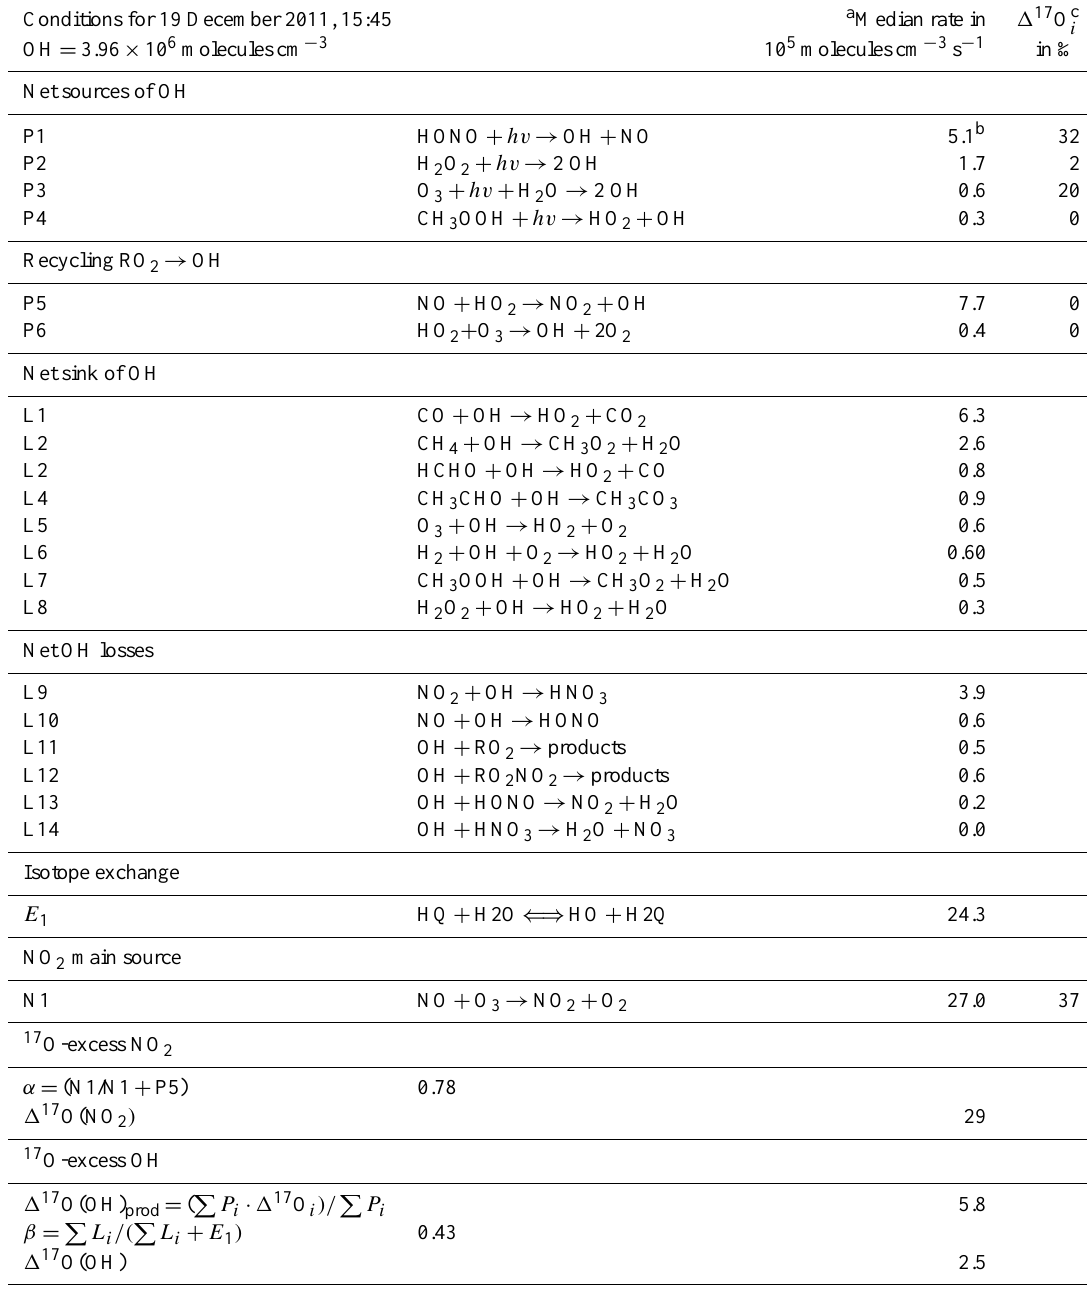
Table 1. Example of mass balance calculation of (cid:49) 17 O for 19 December 2011 at 15:45 local time (UTC + 8h). Conditions for 19 December 2011,